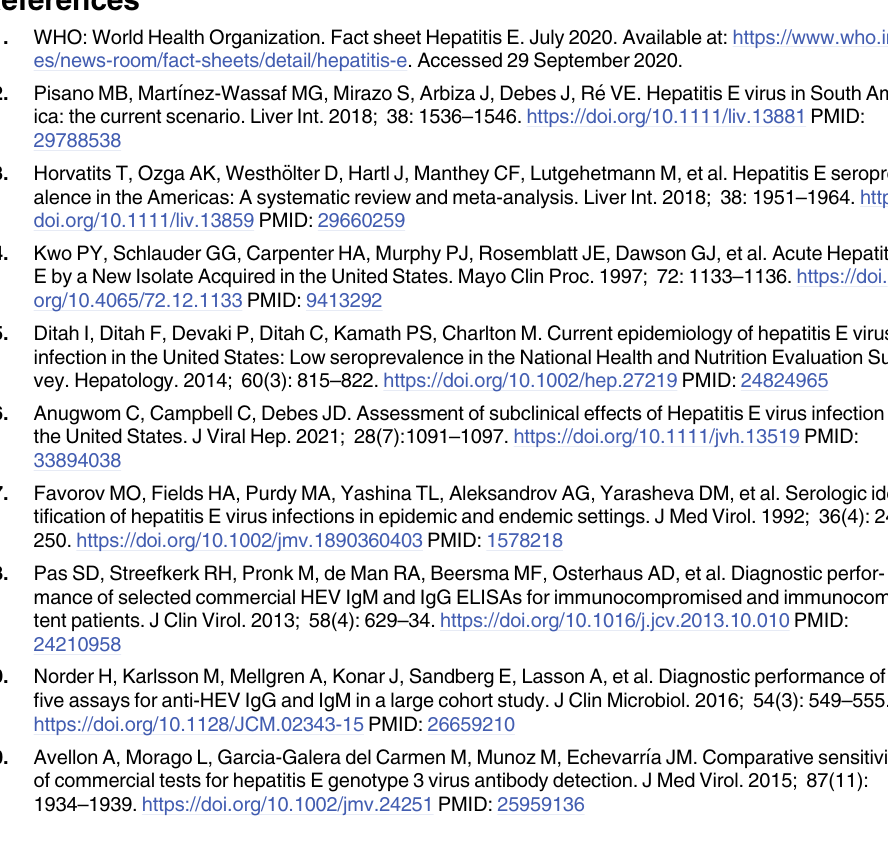
S1 Table. Seroprevalence of HEV in the United States 2009–2016. S2 Table. Summary of individual models of HEV infection risk in U.S. (2009–2016) adjusted for age and